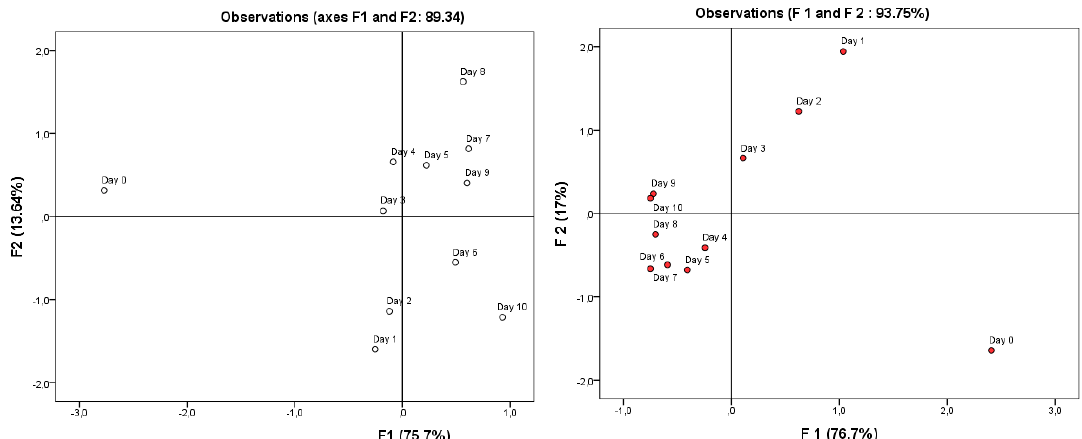
Figure 9. Principal Component Analysis scores plots derived using the physicochemical values of indigenous white beer ( left ) and red beer ( right ) samples for ten days of fermentation.